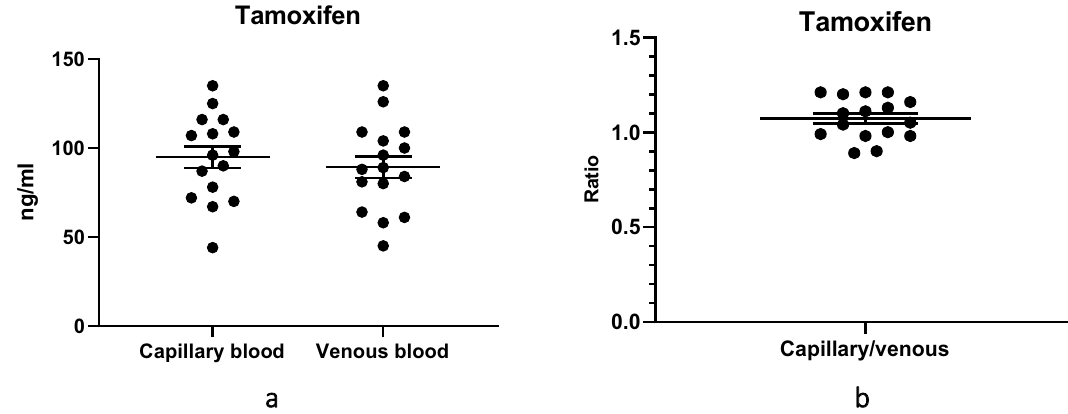
Figure 3. Tamoxifen (TAM) concentrations in 16 participants with breast cancer taking tamoxifen 20 mg daily: ( a ) Distribution of TAM concentrations in capillary blood and in venous blood. The means were not significantly different ( P = 0.525); ( b ) Distribution of ratios of capillary blood to venous blood tamoxifen (TAM) concentrations. In both graphs, the longer horizontal lines represent means (of concentrations or ratios), and the shorter horizontal lines represent standards of the mean (SEM).